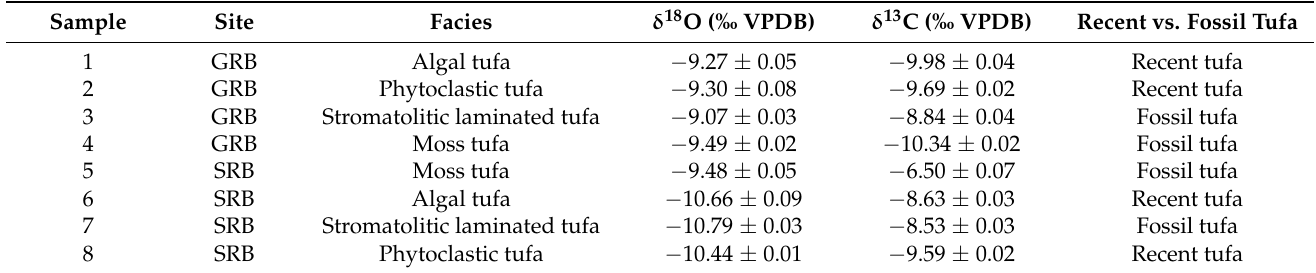
Table 1. Stable isotope values in different tufa